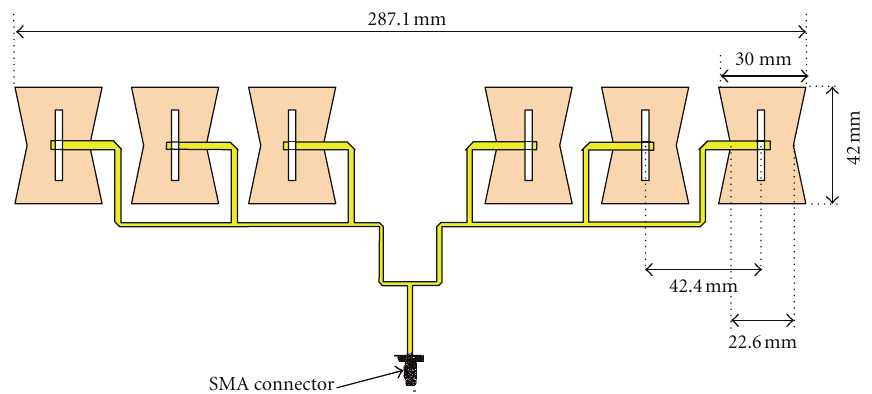
Figure 4: Mask of the multilayered bow-tie antenna array operating at the frequency 2.4GHz.